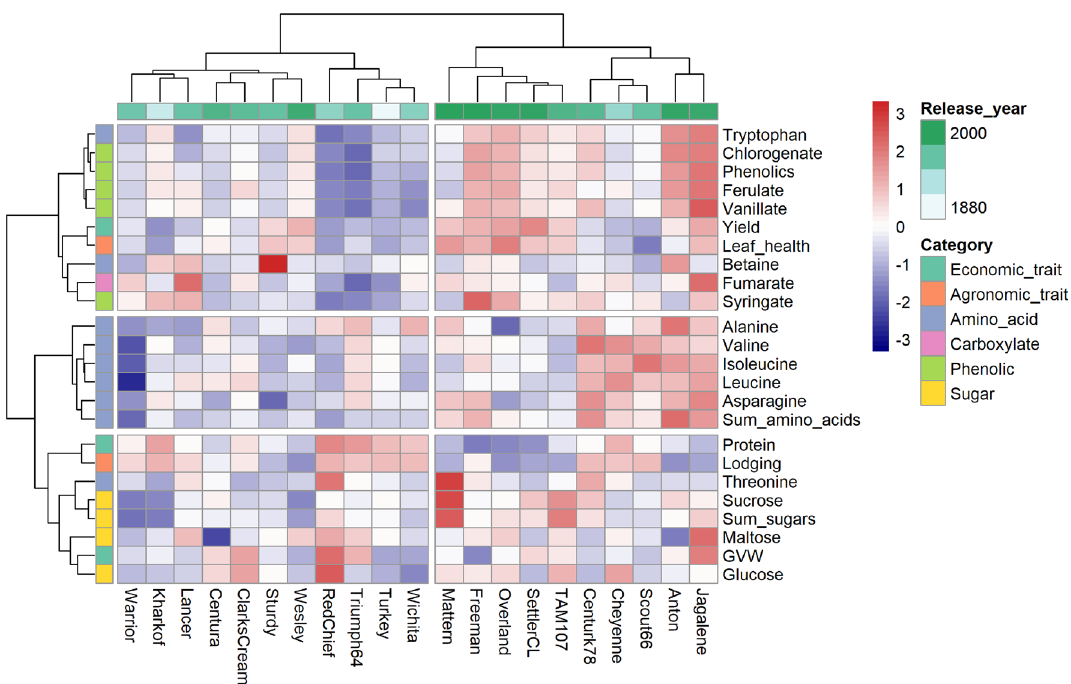
Figure 4. Heat map and hierarchical clustering analysis by Euclidian distance using Ward’s method generated from economic and agronomic traits and wheat metabolites; plot generated using the ‘pheatmap’ package in R 37,38